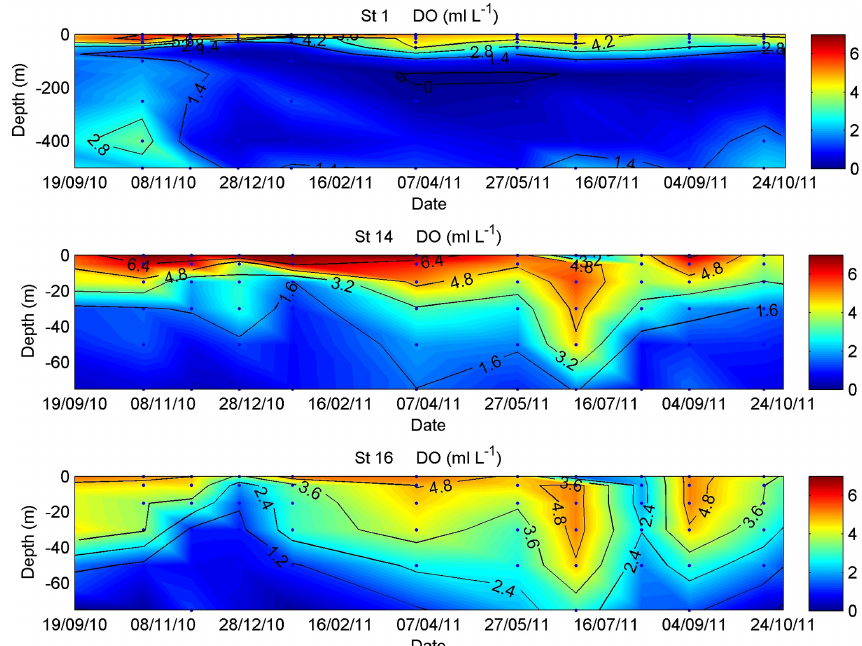
Figure 3. Dissolved-oxygen time series in the water column measured between October 2010 and January 2011 at stations St1, St14 and St16 off Tongoy Bay, Coquimbo (30 ◦ S).